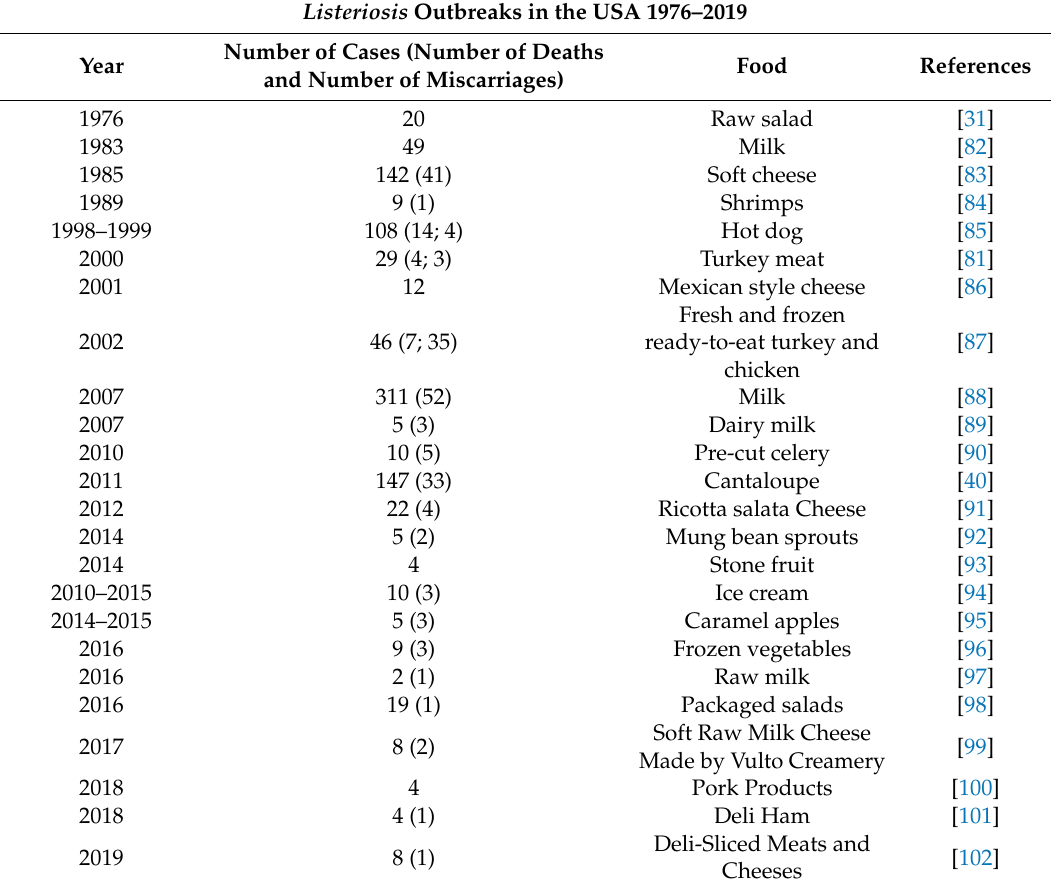
Table 1. Outbreaks of Listeriosis in the USA,